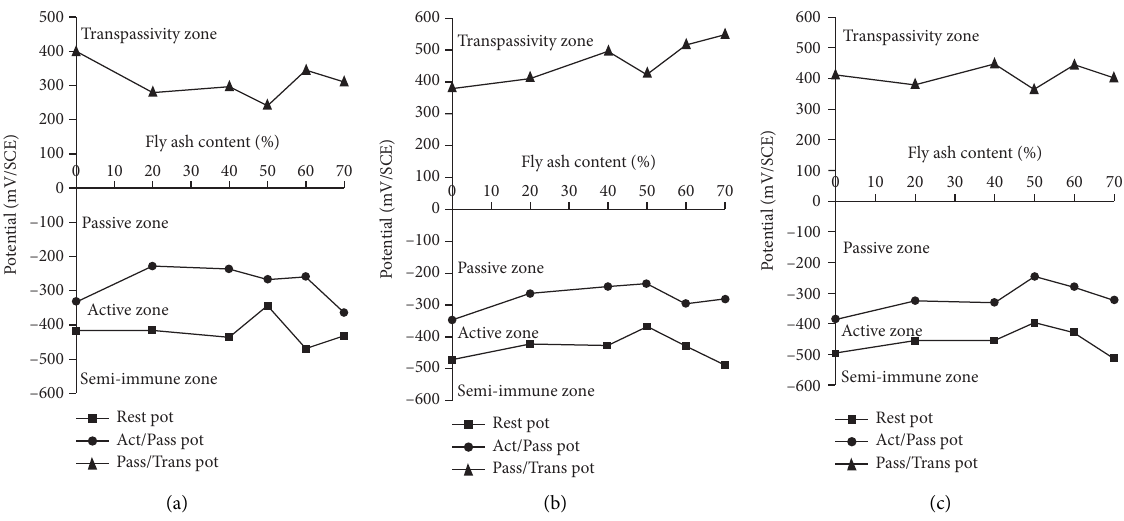
Figure 7: Potential versus different fly-ash content for w/b ratio of 0.45. (a) CRS (b) Tata TMT. (c) Local TMT.